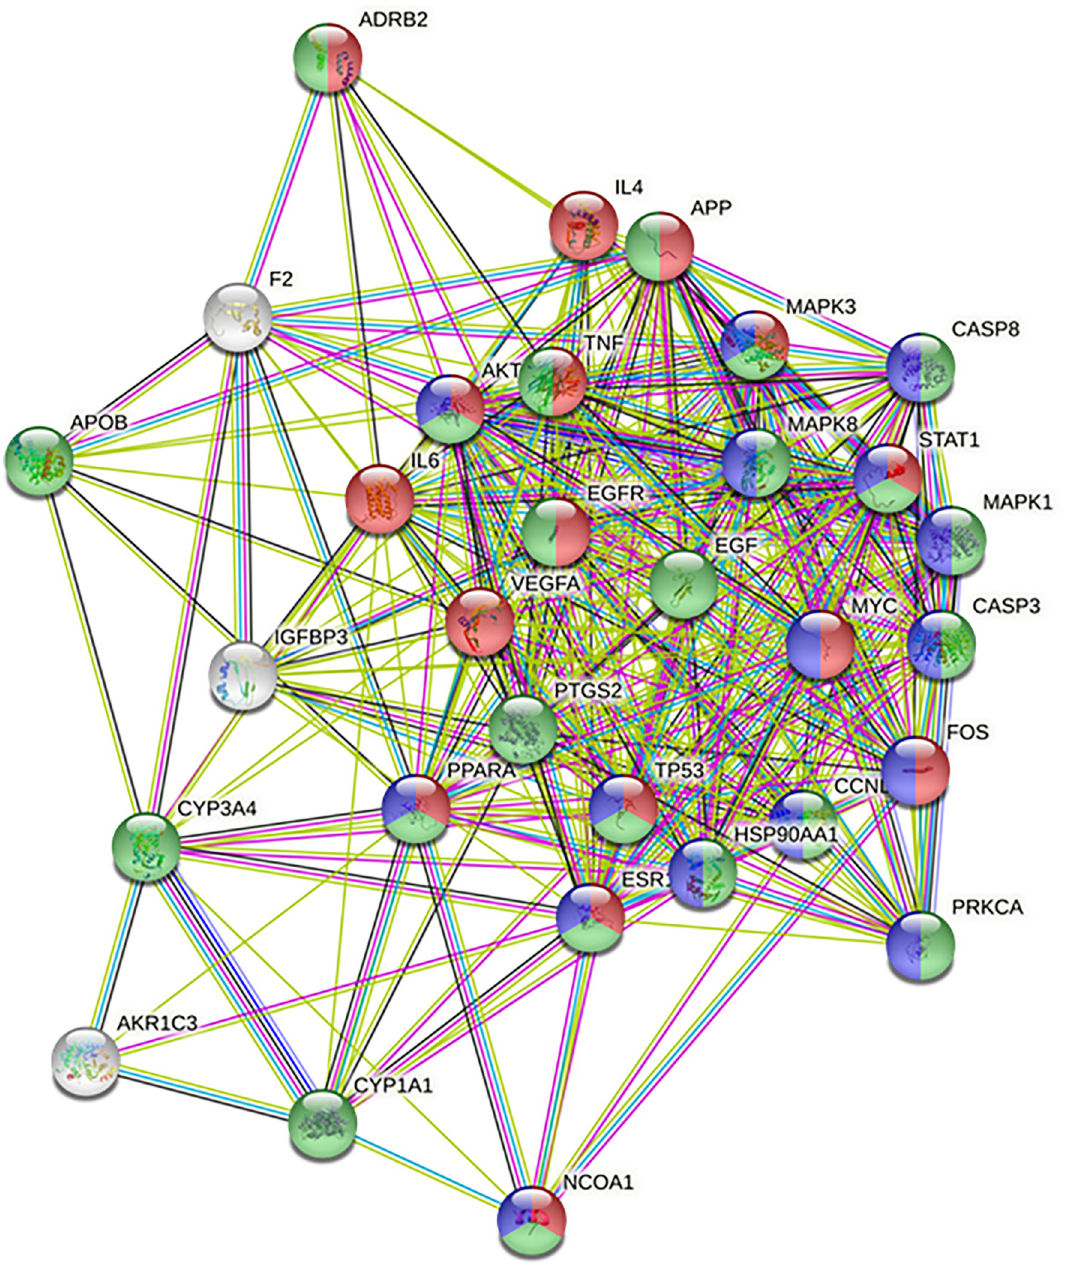
Fig 4. PPI network of the 31 key targets of EH-CS. Thirty-one nodes and 308 interactions between nodes are represented. Red nodes represent genes with dominant BP terms (positive regulation of transcription from RNA), blue nodes represent genes with dominant CC terms (nucleoplasm), and green nodes represent genes with dominant MF terms (enzyme binding).